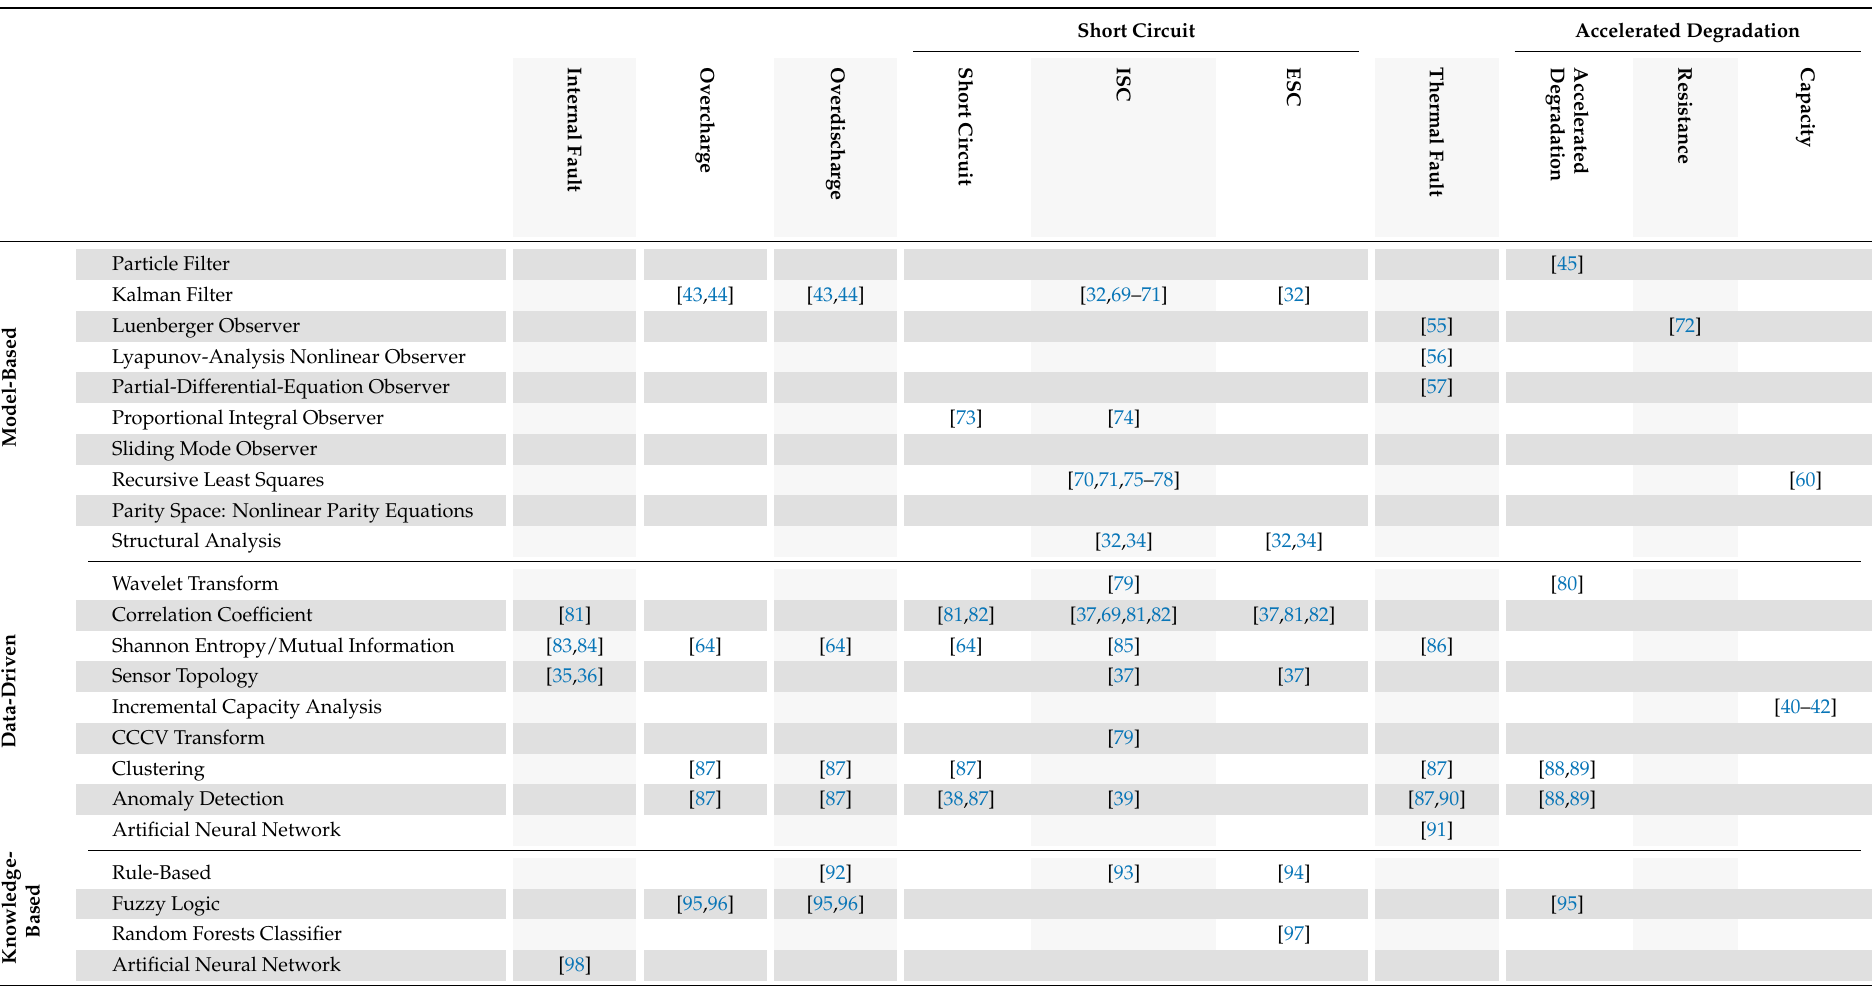
Table 2. Overview of literature related to fault diagnosis of internal faults